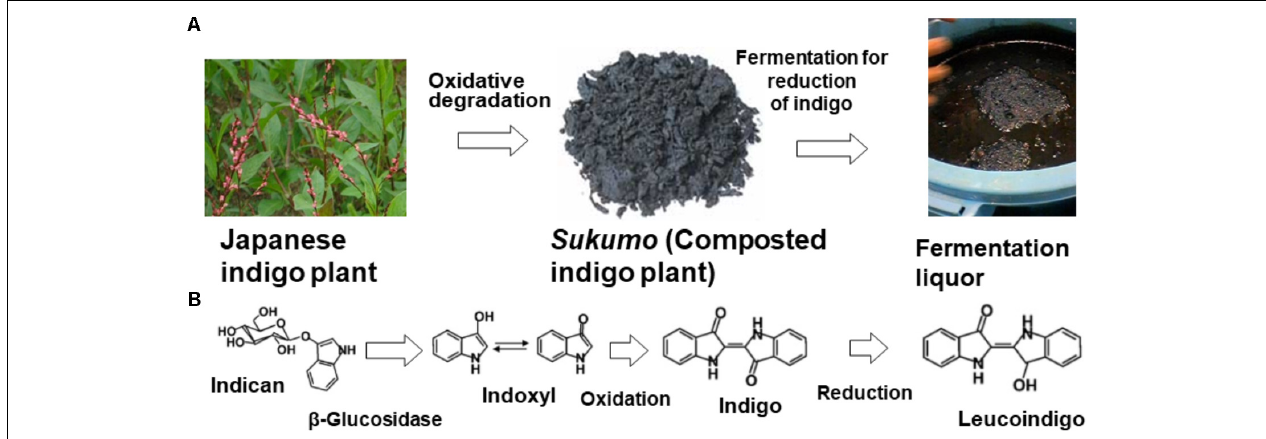
FIGURE 1 | Scheme for indigo dyeing via the traditional fermentation method using indigo plant leaves (A) and the concomitant chemical changes in the dye (B) . The origin of the dye is indican, present in the Japanese indigo plant. Indican is transformed during the production of sukumo . Indigo is reduced by the action of indigo-reducing bacteria and is transformed to